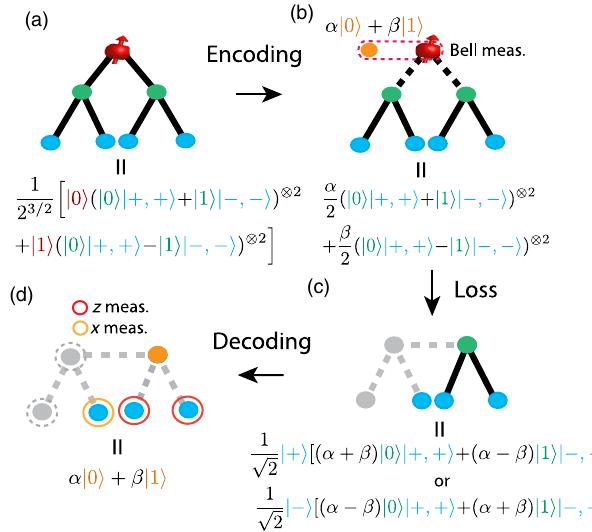
FIG. 2. Sketch of the principle behind counterfactual error correction in the tree-cluster encoding. A [2, 2] tree is considered for simplicity (a). A qubit α j 0 i þ β j 1 i is encoded through a Bell measurement between this qubit and the root spin qubit (b). Loss of qubits (gray vertices) from one branch (c) still allows retrieving the encoded information by measuring at least one remaining second-level qubit in the x basis and the second-level qubits of the intact branch in the z basis (d) despite the fact that we do not get any information from (attempted) measurements on the lost photons (dashed